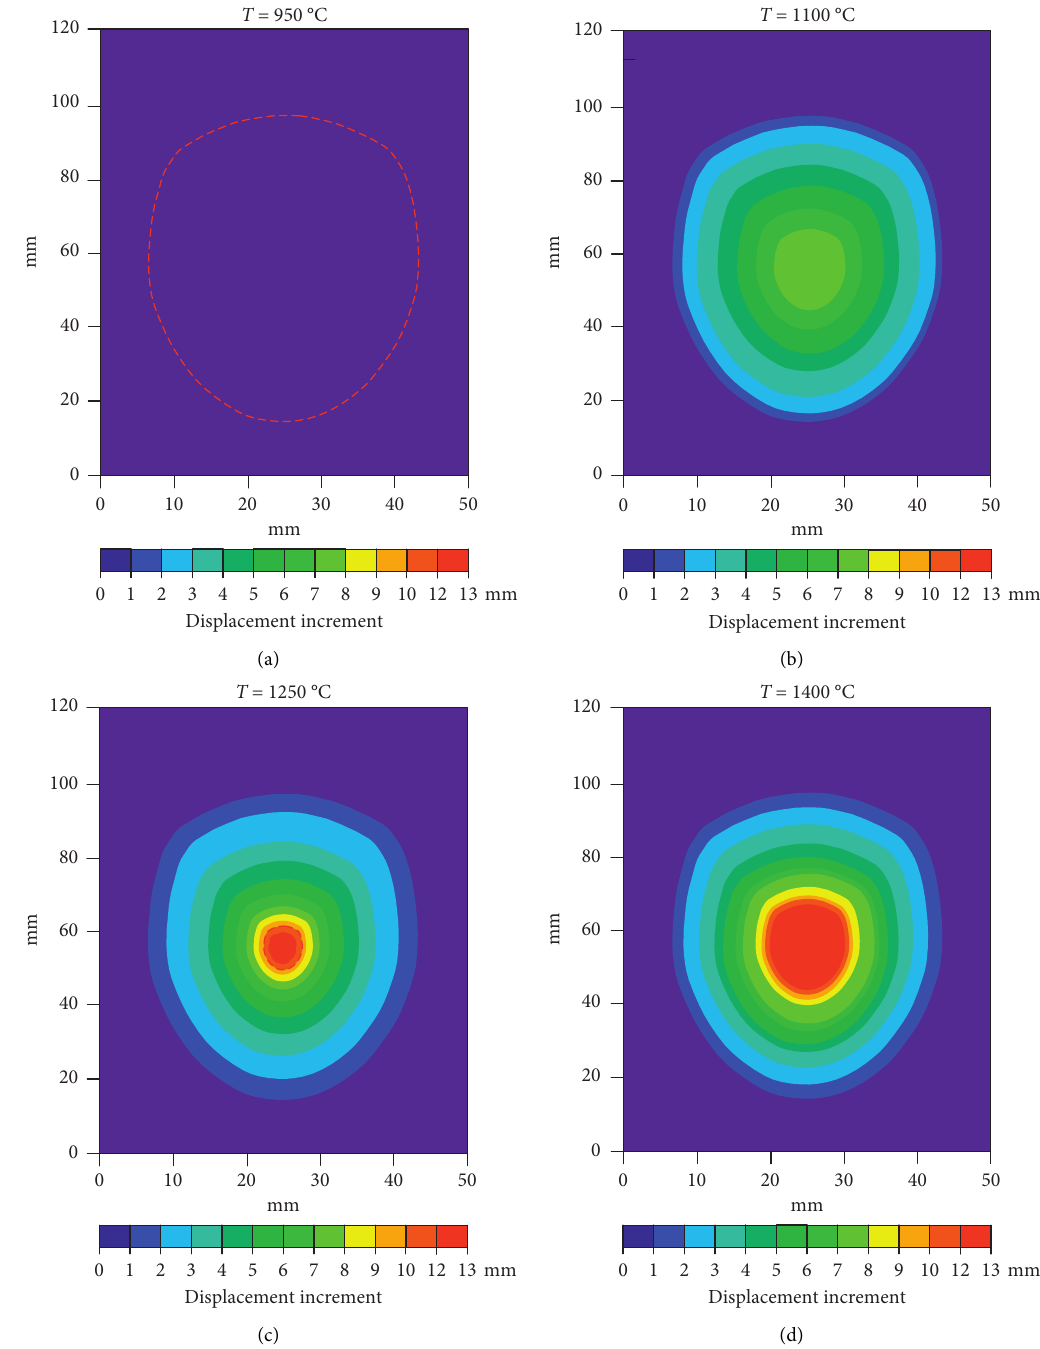
Figure 4: Numerical simulation results of displacement increment for mental material at different remelting temperature in solid-state